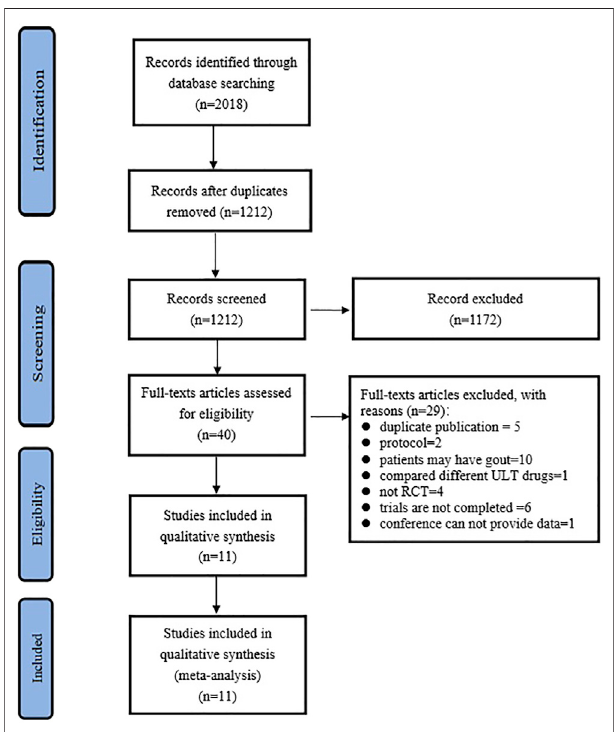
FIGURE 1 | PRISMA Flow diagram of the